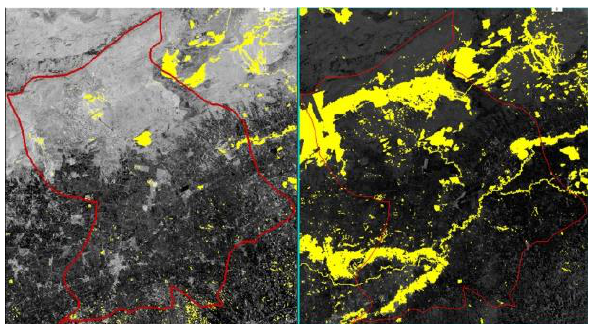
Figure 4. Extracted water bodies from MNDWI image before (left) and after (right) flood, water bodies area appears as yellow pixels.